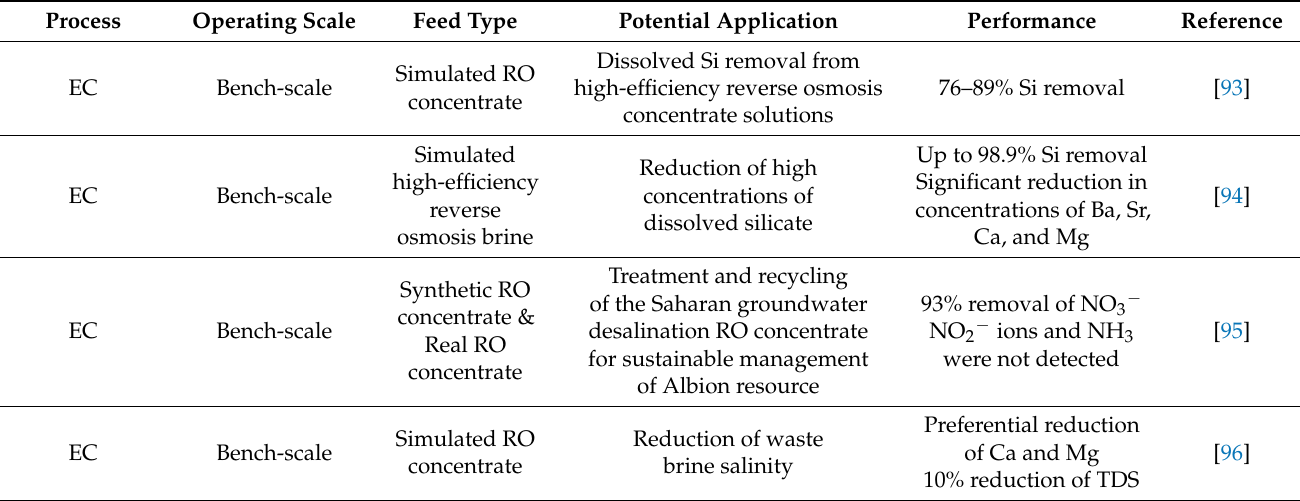
Table 9. Summary of recent literature on brine treatment by